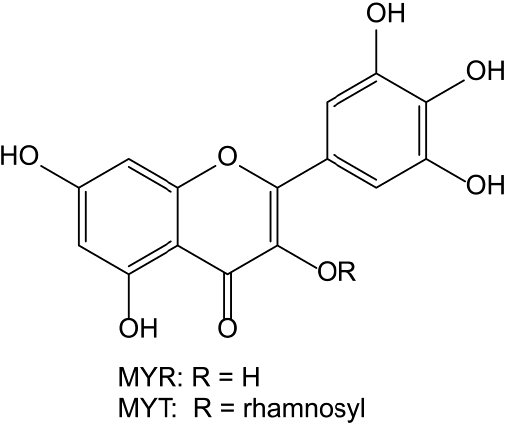
Figure 1. Chemical structures of MYR and MYT.